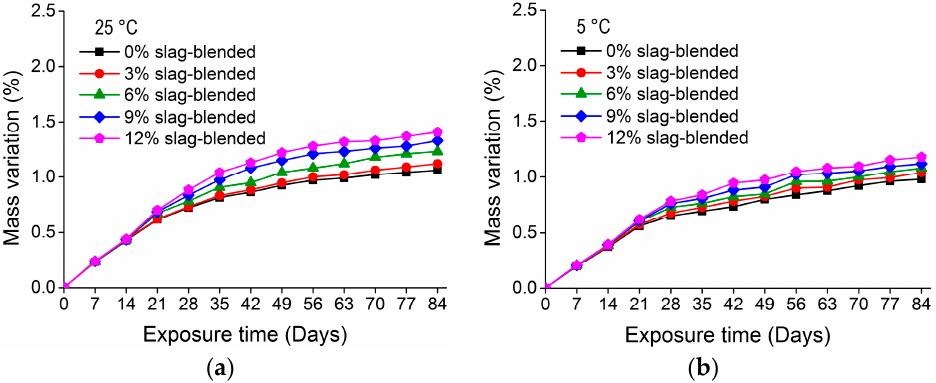
Figure 8. Mass variation in nano-TiO 2 containing slag-blended mortars immersed in 10% Na 2 SO 4 solution at ( a ) 25 °C; ( b ) 5 °C.